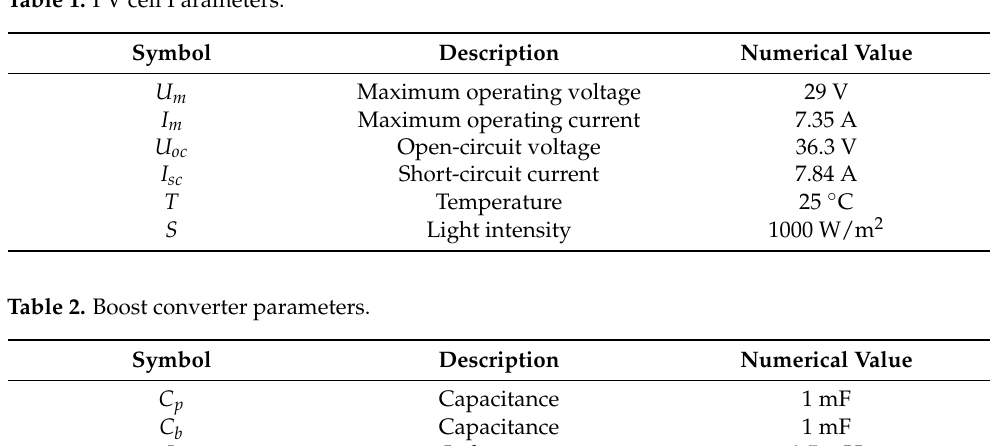
Table 1. PV cell Parameters.